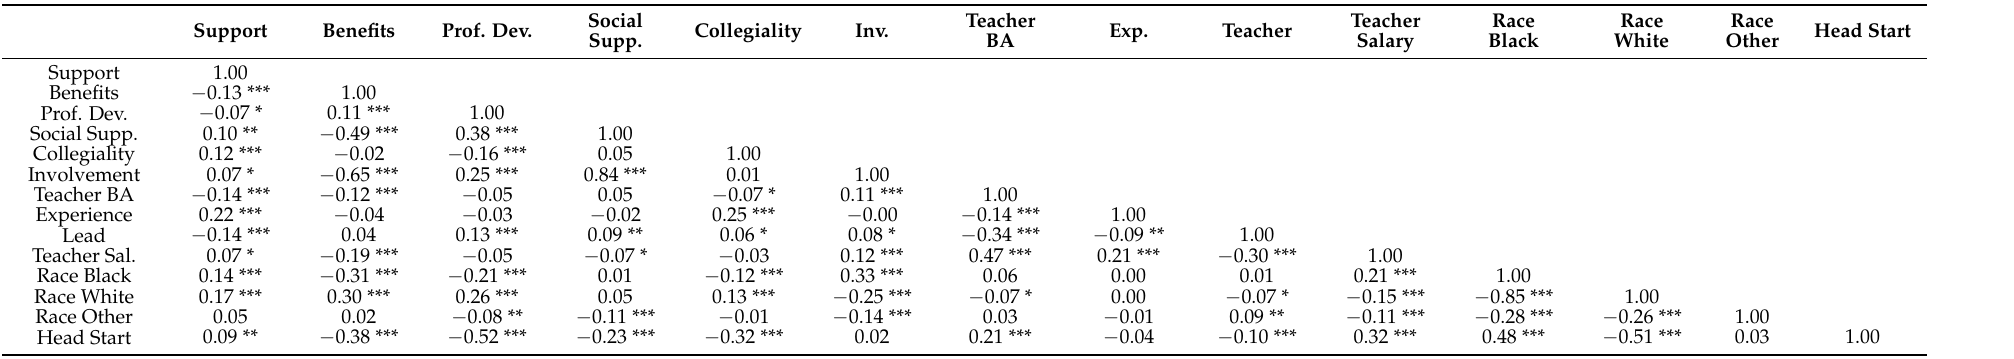
Table 3. Bivariate